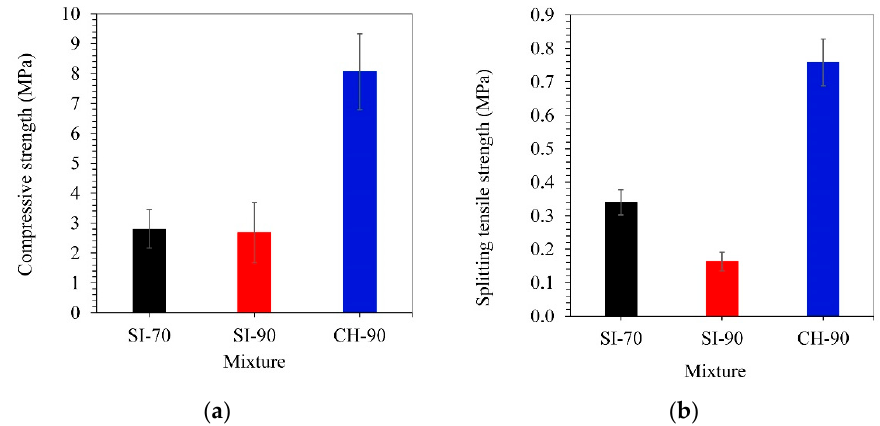
Figure 4. ( a ) Compressive and ( b ) splitting tensile strength for SI and CH mixtures.